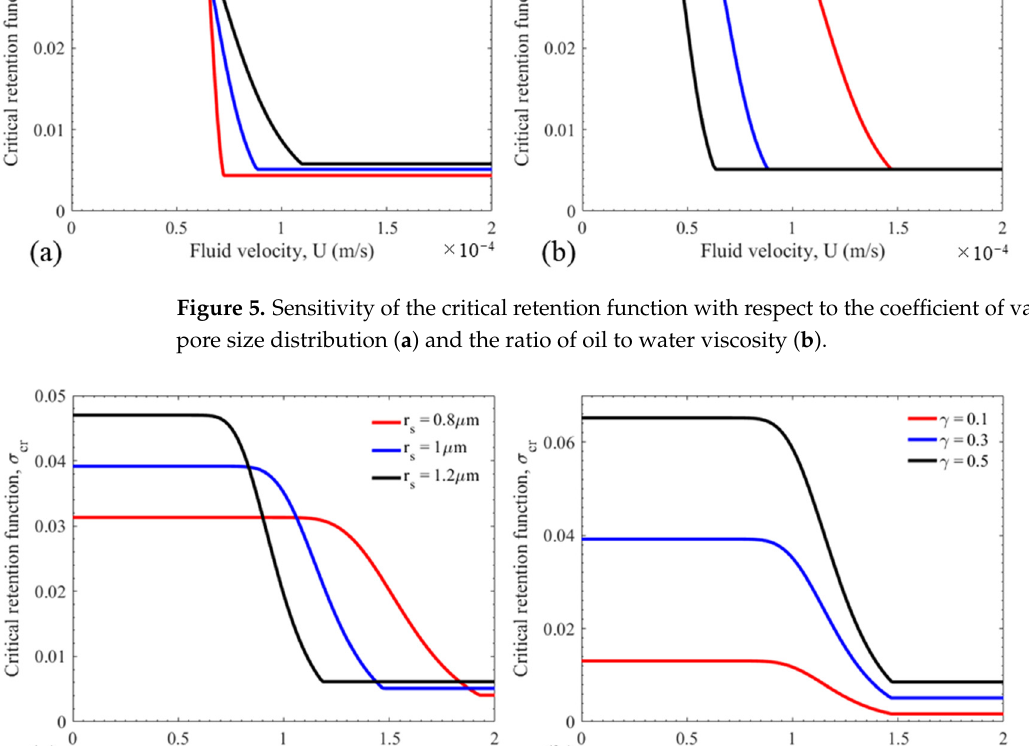
Figure 6. Sensitivity of the critical retention function with respect to the particle radius ( a ) and the fraction of internal surface coverage ( b ). fraction of internal surface coverage ( b